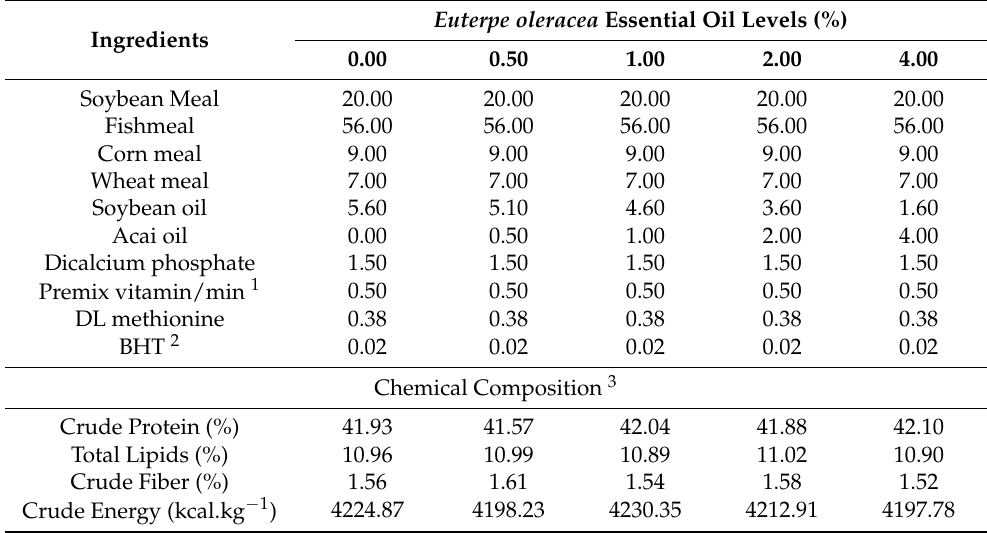
Table 1. Values of the percentage and chemical composition of the experimental